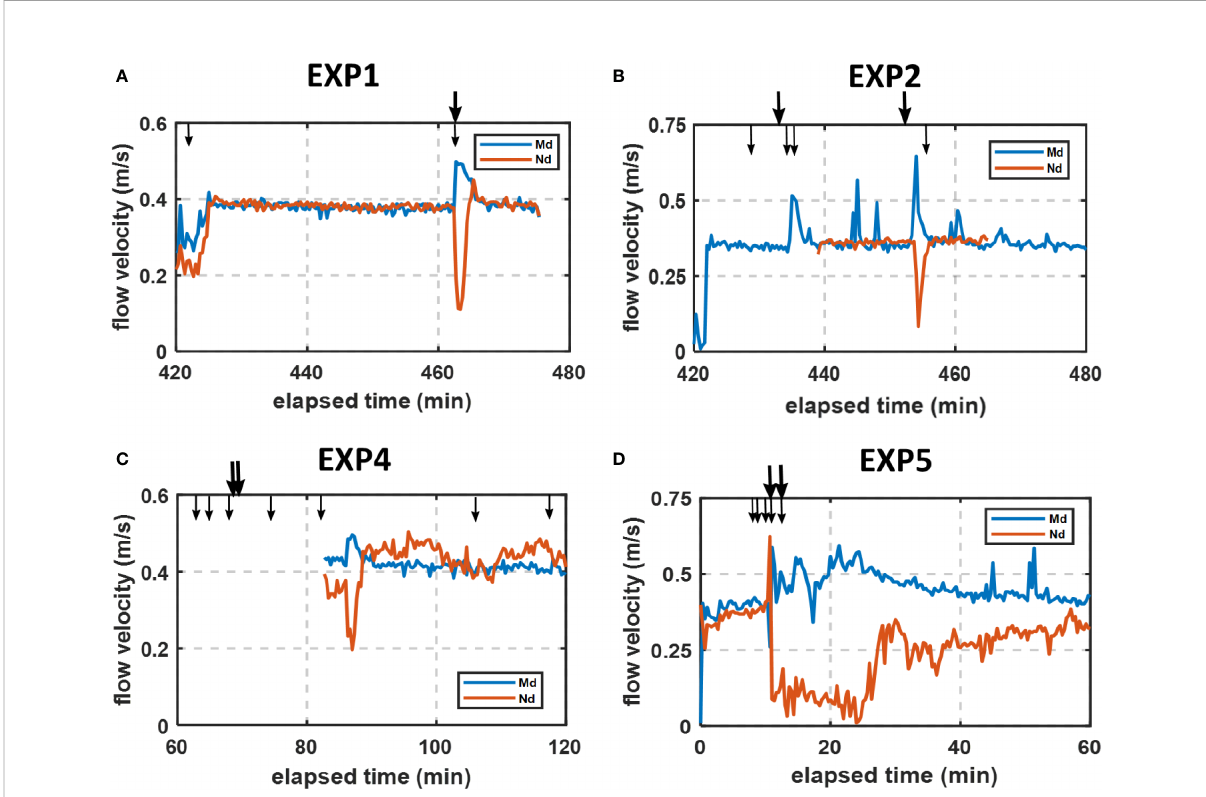
FIGURE 7 Flow velocity during each experiment and occurrence of bank failures: (A) EXP 1; (B) EXP 2; (C) EXP 4; (D) EXP 5. Md and Nd indicate midchannel and near-bank velocity of downstream, respectively. Flow direction is consistent with Figure 2A. Arrows are consistent with Figure 5. Position of sensors can be found in Figure 2 and Table 2. Due to the trouble of the velocity probe in the experiment, the velocity data of about the fi rst 19 min in EXP 2 (Nd) and the fi rst 22 min in EXP 4 were unfortunately